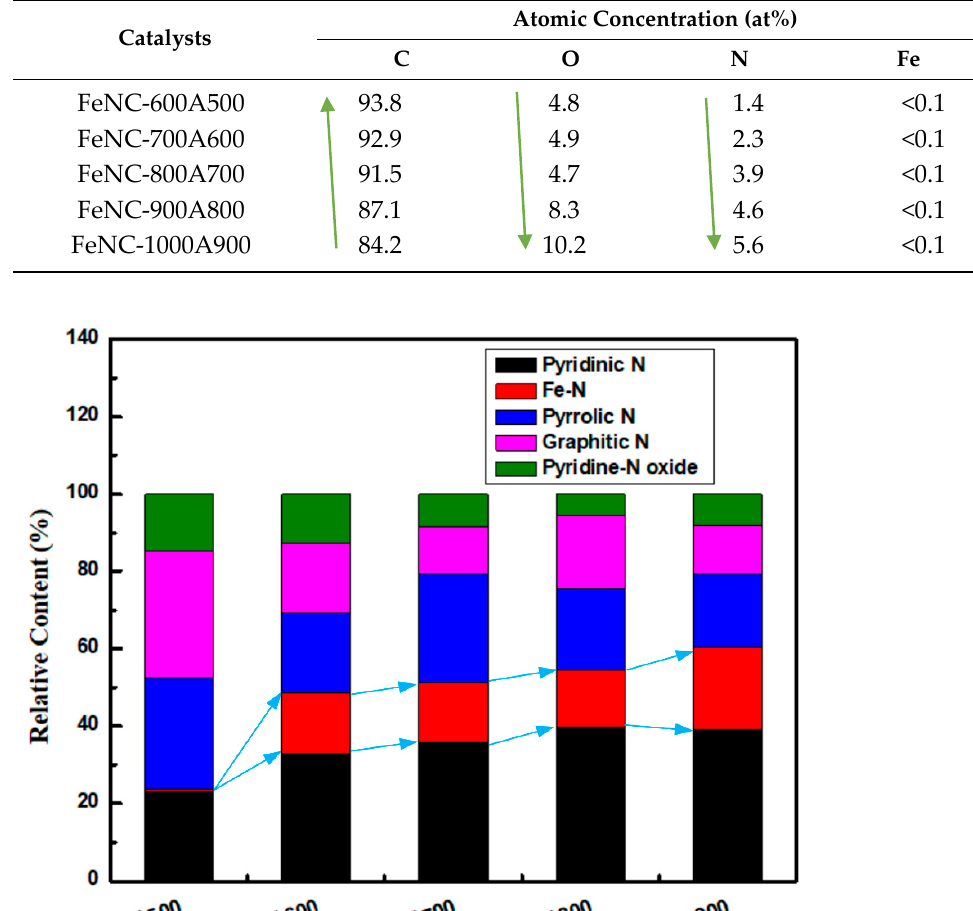
Table 1. Table 1. Atomic concentration obtained from XPS of FeNCs prepared with different calcination calcination methods. methods.